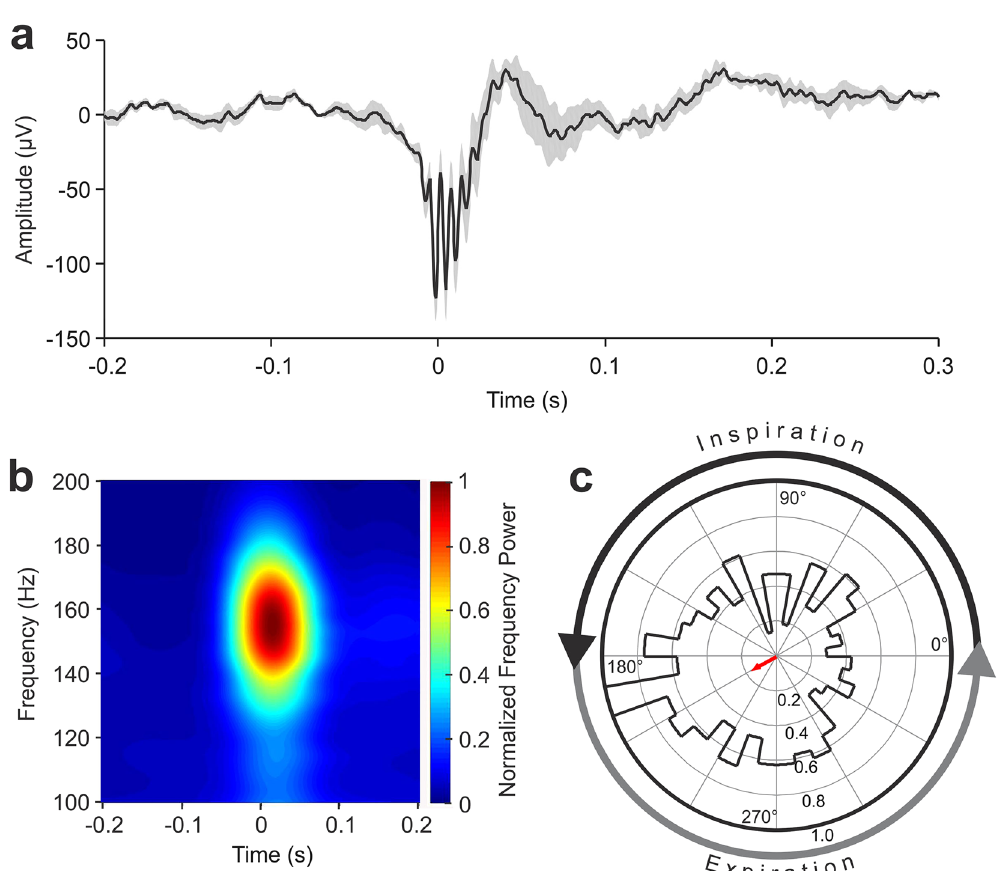
Figure 3. Hippocampal sharp-wave ripple (SWR) activity in relation to the respiratory cycle in mice. ( a ) Average local field potential (LFP) aligned on hippocampal SWRs (mean + / − standard error). Data are aligned on the onset of ripple-activity (at time 0 s). ( b ) Time-Frequency mapping of LFPs around CA1 ripples. Color represents normalized frequency power. ( c ) Polar plot reflecting the distribution of SWR events relative to respiratory phase. Red arrow represents the mean vector determined by circular statistics (Rayleigh test: n = 382; r = 0.14; z = 7.35; p = 0.02). 0° represents the end of expiration, 180° corresponds to the end of inspiration. Concentric circles mark r values as indicated in the lower half of the